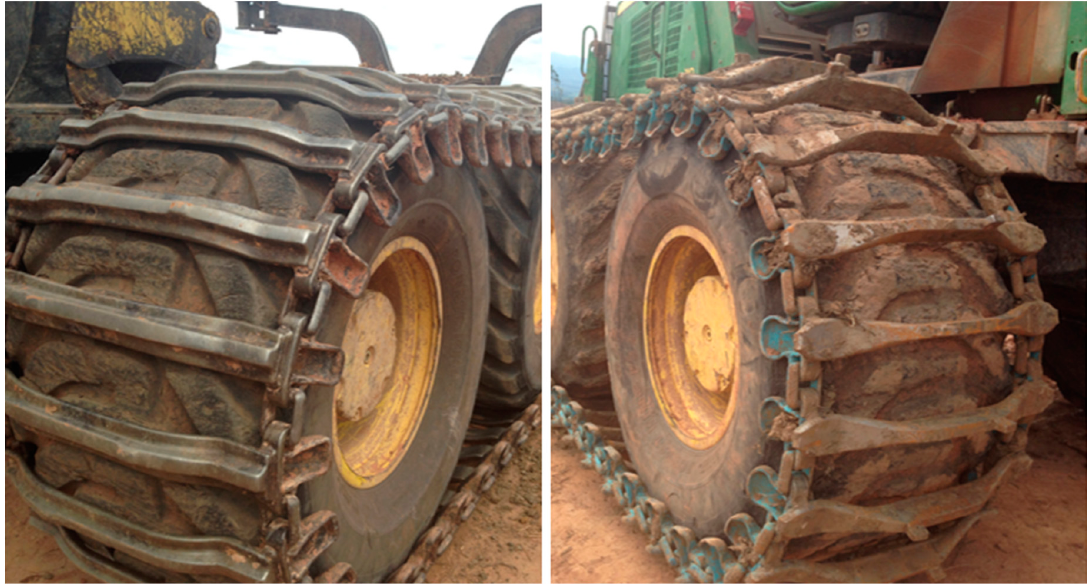
Figure 3. Olofsfors ECO-Soft bogie track, left, (mild track) and Olofsfors EX bogie track, right (aggressive track).